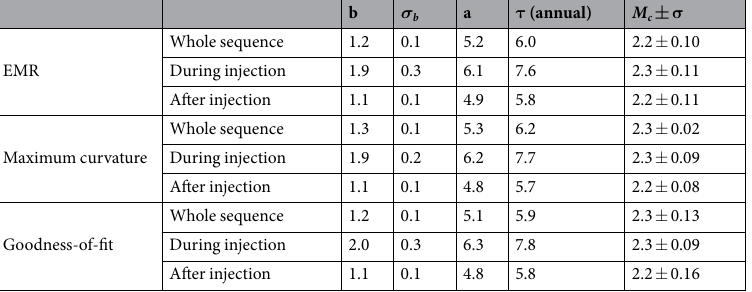
Table 3. Summary of GR parameters and minimum magnitude of completeness (M c ) obtained applying three different methods: EMR, maximum curvature and goodness-of-fit. τ (annual) represents the annual rate of events with M ≥ M c . The values of M c are consistent among the different used methods of estimation within ± 0.1 (a summary description of methods is given in